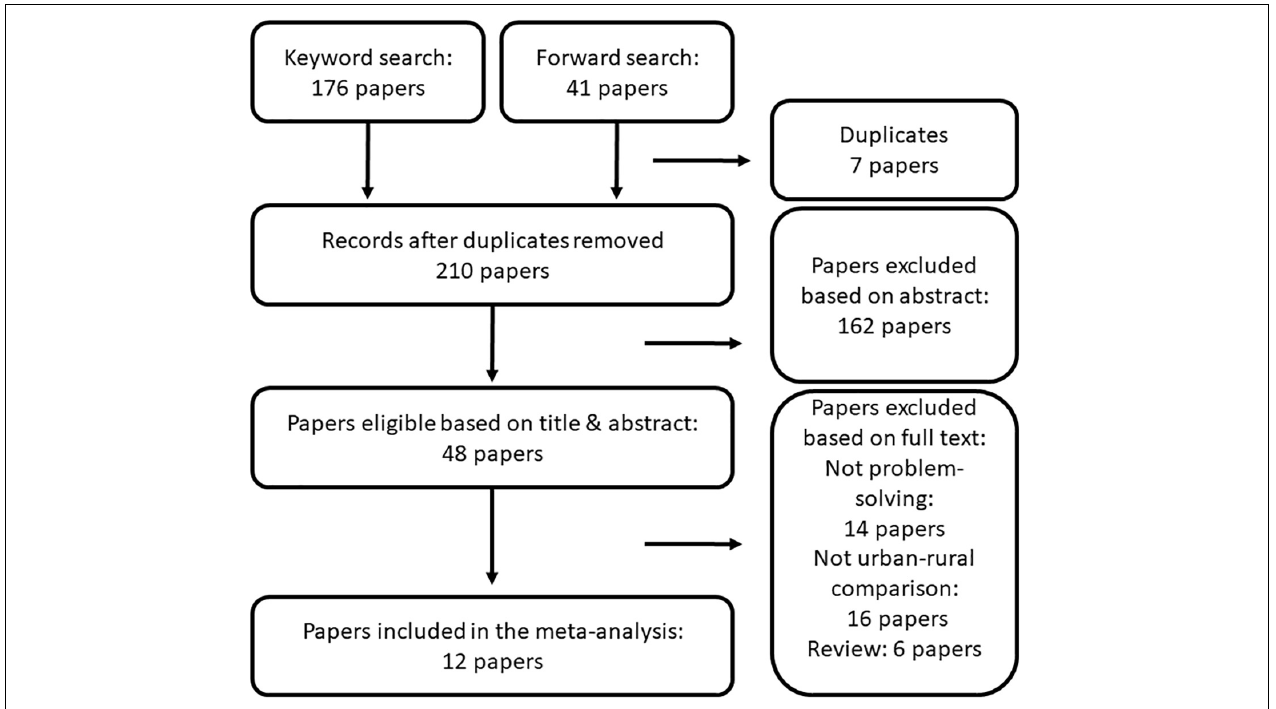
FIGURE 1 | PRISMA diagram of our literature